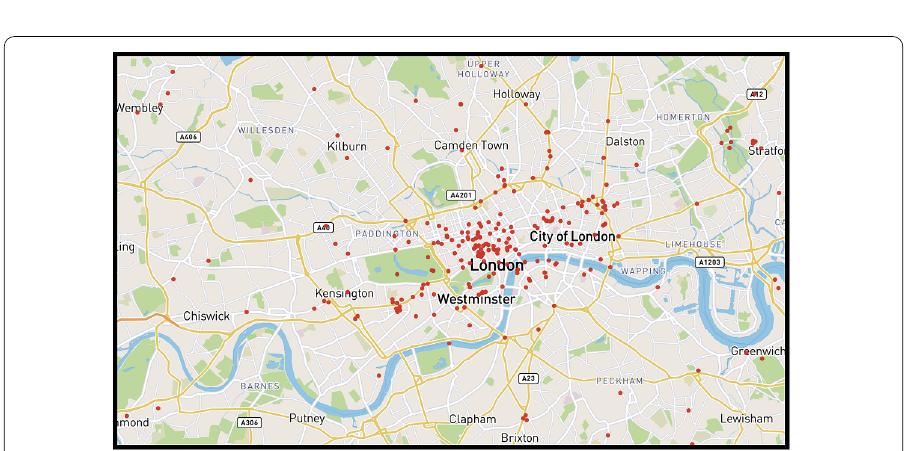
Figure 5 Set of new venues. Coordinates of the set of 305 new venues in London considered in the study